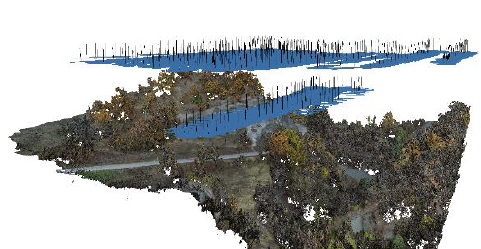
Figure 4. The two nadiral blocks acquired at 40 and 15 metres above the main road level. The generated dense point cloud is used as representation of the outcrop.